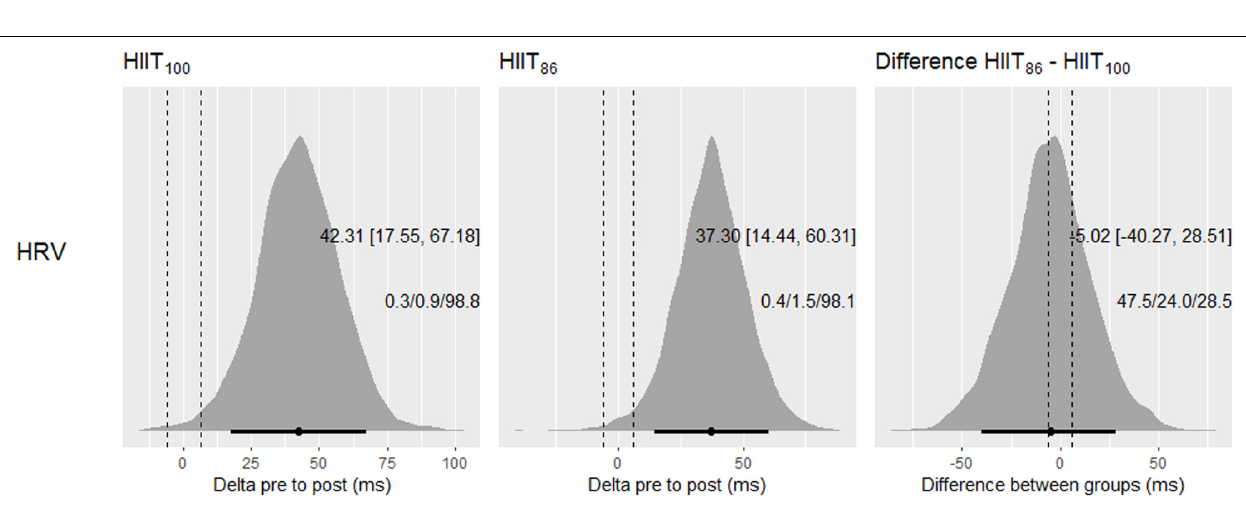
FIGURE 3 | Posterior density distributions and the respective means with 90% credible intervals of the pre to post changes in RSA BEST , RSA MEAN , Sprint 15-m, CMJ, and SJ (upper to lower panels, respectively) in each HIIT model, and the comparison of changes between models. The effects are adjusted to baseline mean of all study subjects. Black points and error bars are the posterior mean change and 90% credible intervals, respectively. Vertical dashed lines are the lower and upper boundaries of the ROPE (i.e., 0.2 × between subjects SD). The texts in each graph are the means (90% CI) and probabilities against ROPE.